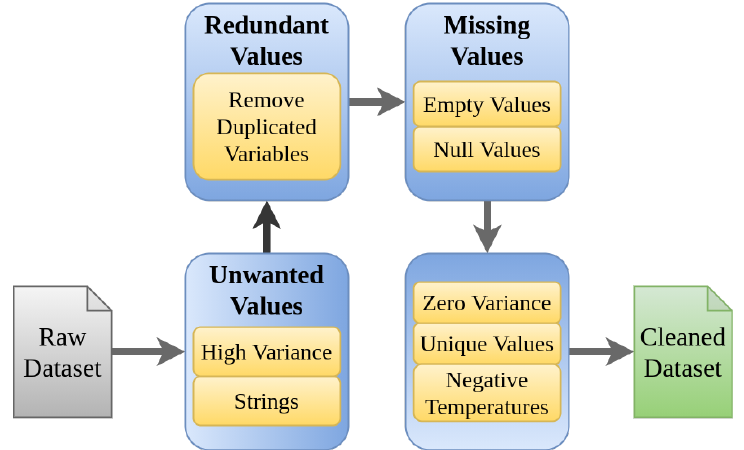
Figure 8. Data cleansing process workflow.